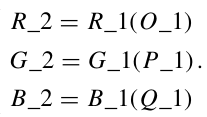
Generation of initial values of chaotic